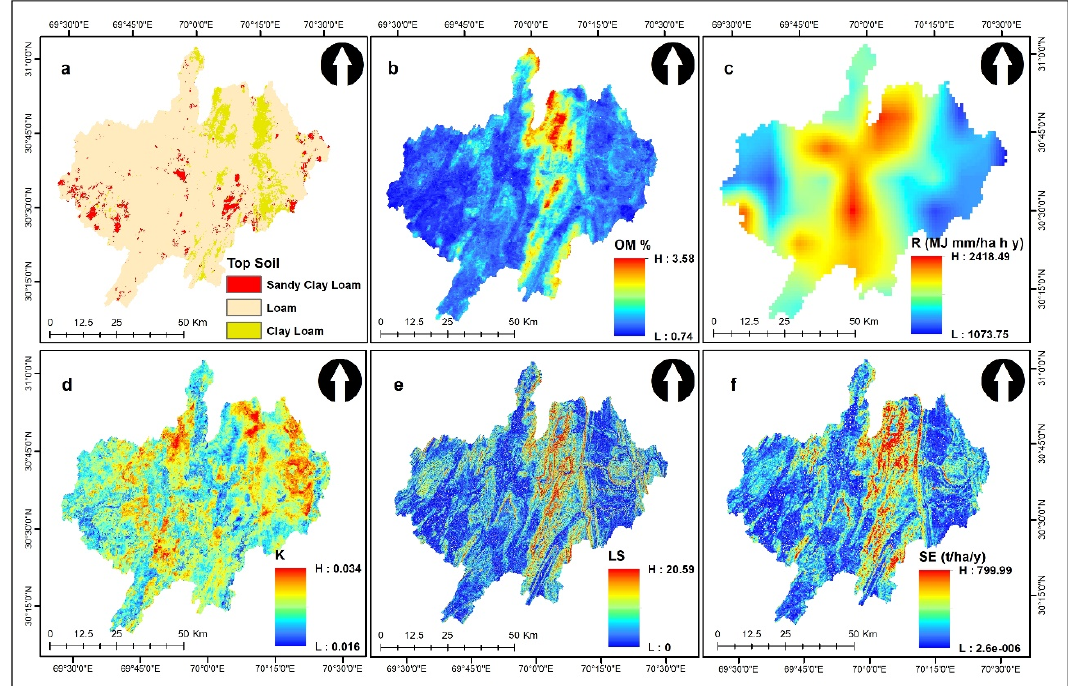
Figure 7. Soil Erosion ( SE) analysis ( a ); soil type, ( b ); percentage OM, ( c ); R-factor, ( d ); K-factor; ( e ); LS-factor, and ( f ); SE. The SE has spatial variability in low values (SE < 50) t-ha −1 y −1 due to the variability of terrain. The low range covers the maximum of the Sanghar catchment. Higher values (SE > 373) t-ha −1 y −1 of SE are observed in the central part of the catchment. The clustered high values of SE in the center of the Sanghar catchment is due to the concentration of high values of R, LS, and K-factors and associated heterogeneity in elevations. SE values (211 < SE < 373) t-ha −1 y −1 are trending in the adjacent cells of higher SE values. However, the value range of (50 < SE < 211) t-ha −1 y −1 covers the rest of the catchment as shown in Figure 8. The generated SE substantiates among the 8 defined ranges, the majority of the area lies in the range (SE < 50) t-ha −1 y −1 as shown in Figure 8.